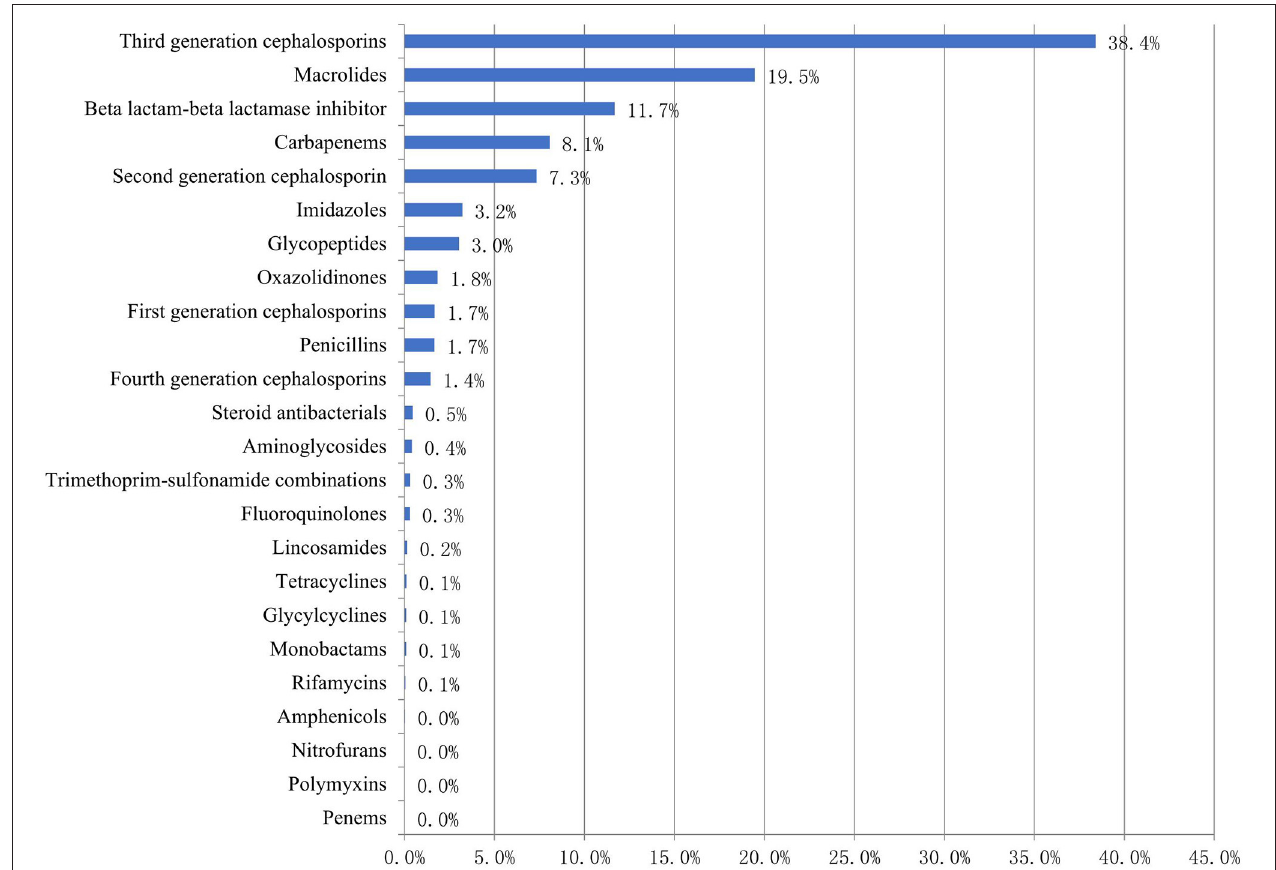
FIGURE 2 | Proportion of prescribed antibiotics (ATC classification) among Chinese children in 2017–2019